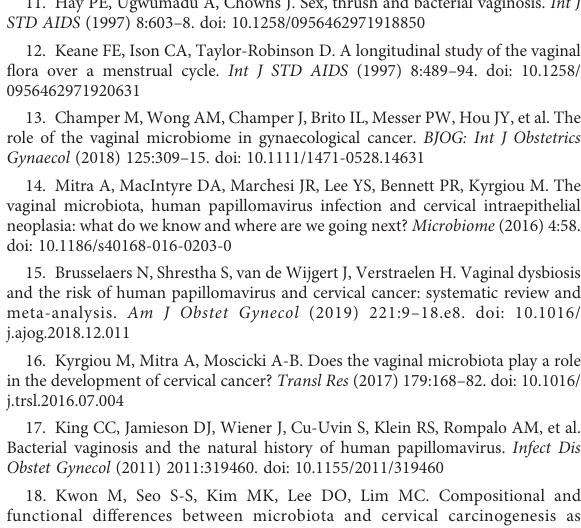
SUPPLEMENTARY TABLE 1 Bacterial counts from MEGAN used to generate. SUPPLEMENTARY TABLE 2 Results of comparison between healthy controls and post- treatment